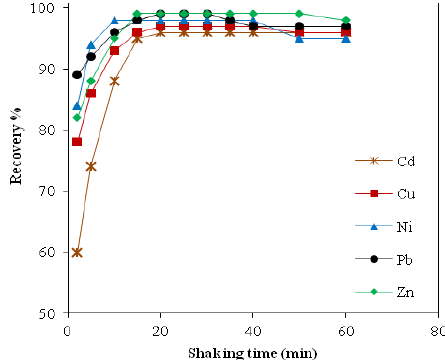
Figure 2. Effect of shaking time on metal ions adsorption. Other conditions: 30 mg of the sorbent, pH 5.0, temperature 25  C, sample volume 10